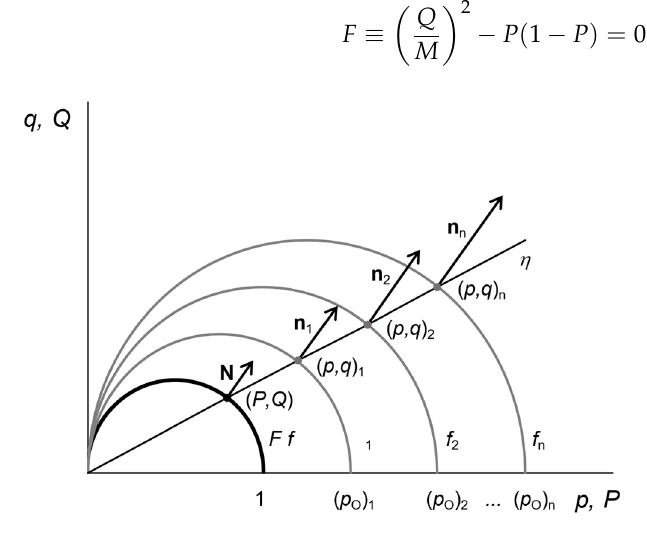
Figure 1. Projection of the different yield surfaces f i on the normalized yield surface F . All the points ( p , q ) i located on the same axis η , although they are associated with a different hardening parameters p Oi , define the same dimensionless stress ( P , Q ) (Figure 1). Moreover, in all of them, the vector n , normal to f , given by the expression